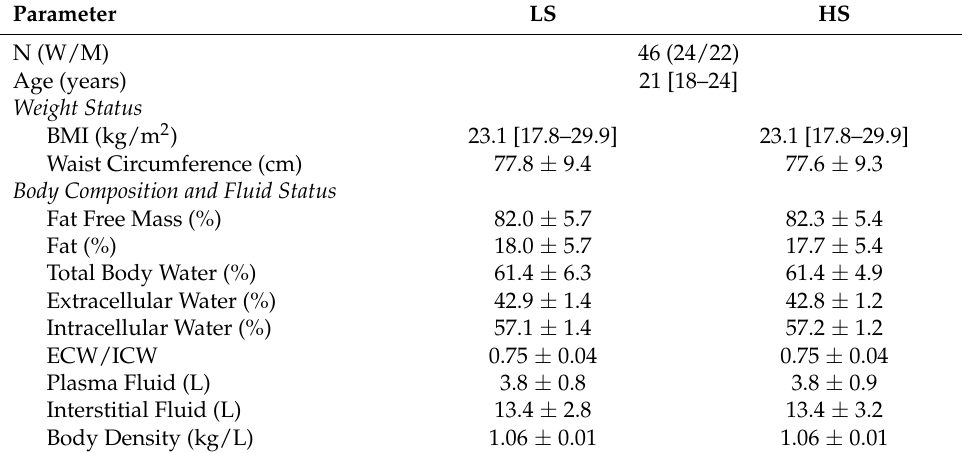
Table 1. Effects of a 7-Day High-Salt Diet on Weight Status, Body Composition and Body Fluid Status in Young Healthy Individuals.